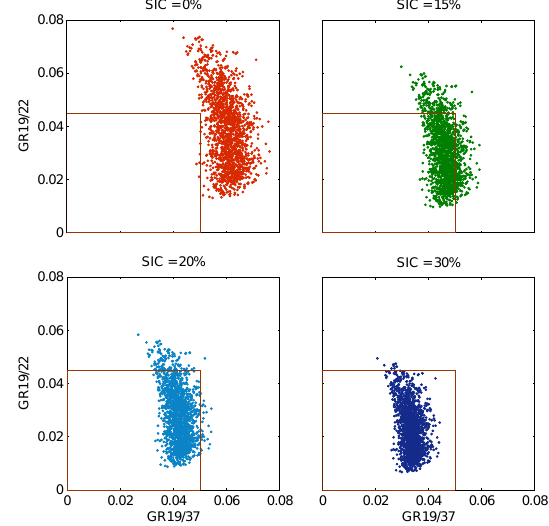
Figure 5. Demonstration of the open water/weather filter per- formance: gradient ratio (GR) 19/22 is plotted as a function of GR19/37 for SSM/I data in 2008 (entire year) for the Northern Hemisphere for sea ice concentration (SIC) of 0, 15, 20, and 30%. The red square shows the value range outside which the open wa- ter/weather filter sets SIC values to 0% (open water).